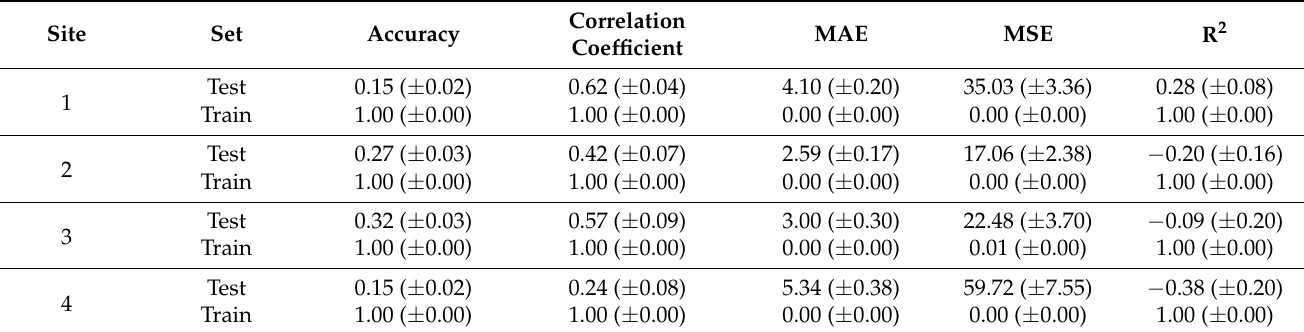
Table 6. Correlations obtained for a fully developed DT.